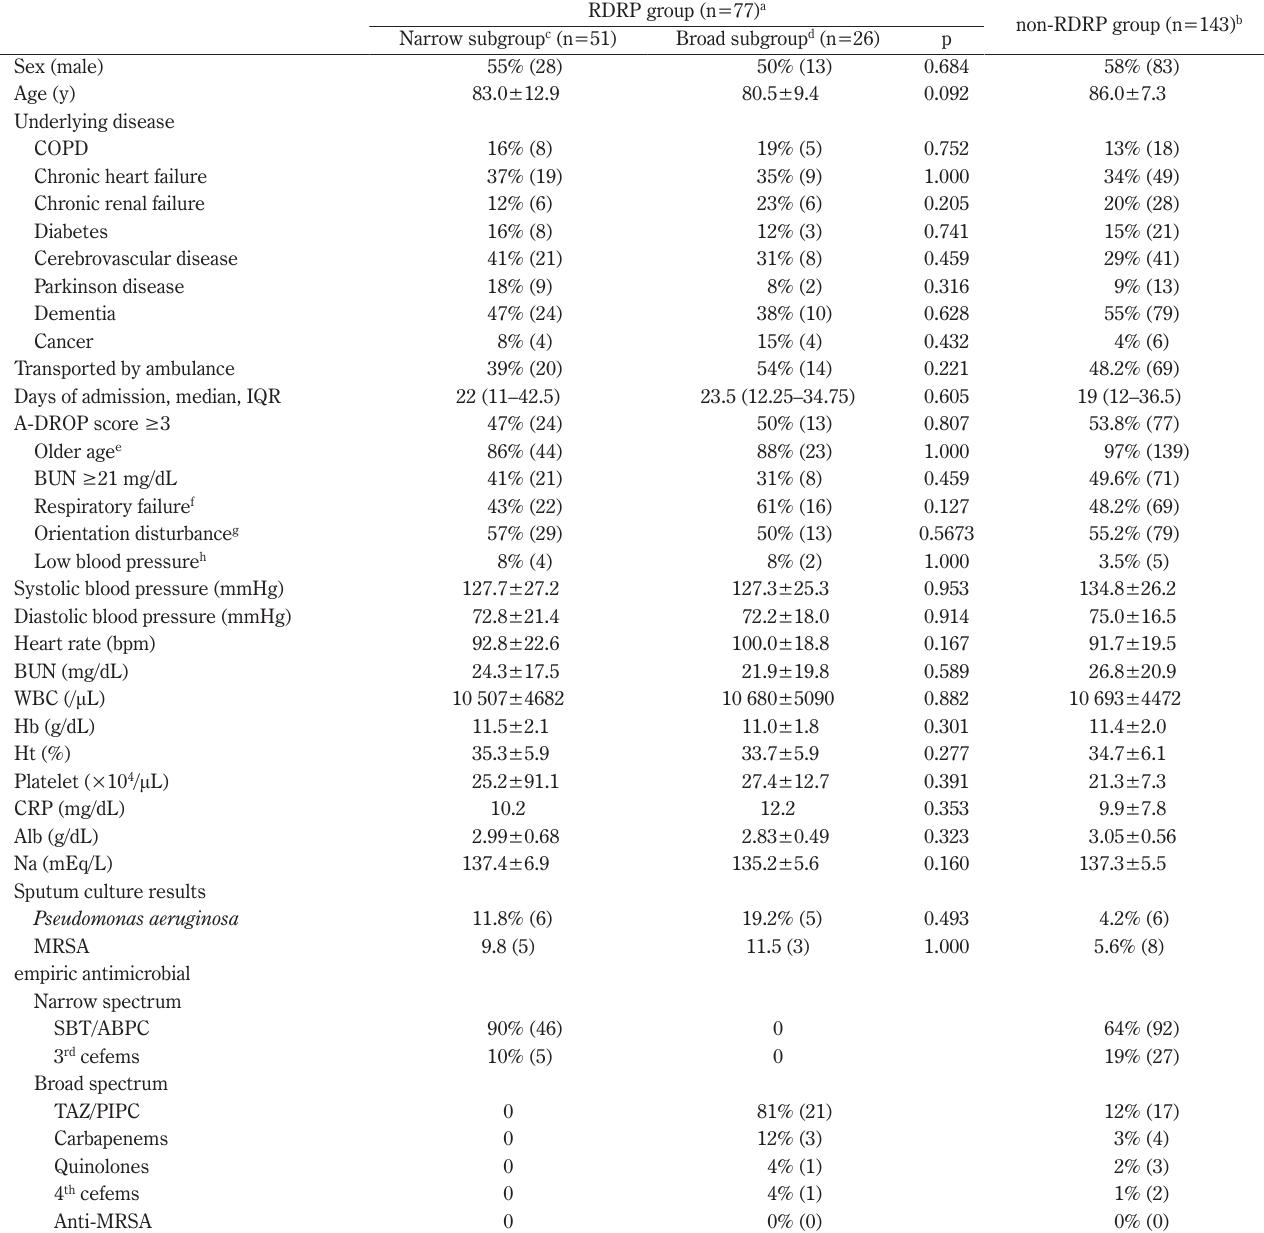
Table 1 Patients’ baseline characteristics